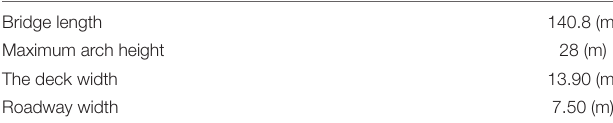
TABLE 1 | Main geometric parameters of the analyzed bridge